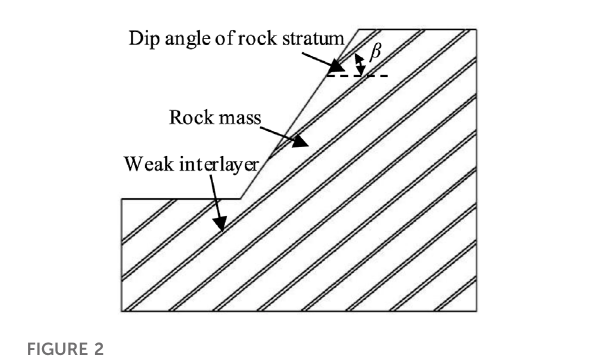
FIGURE 2 The slope model with the dip angle of rock stratum of 30 ° .